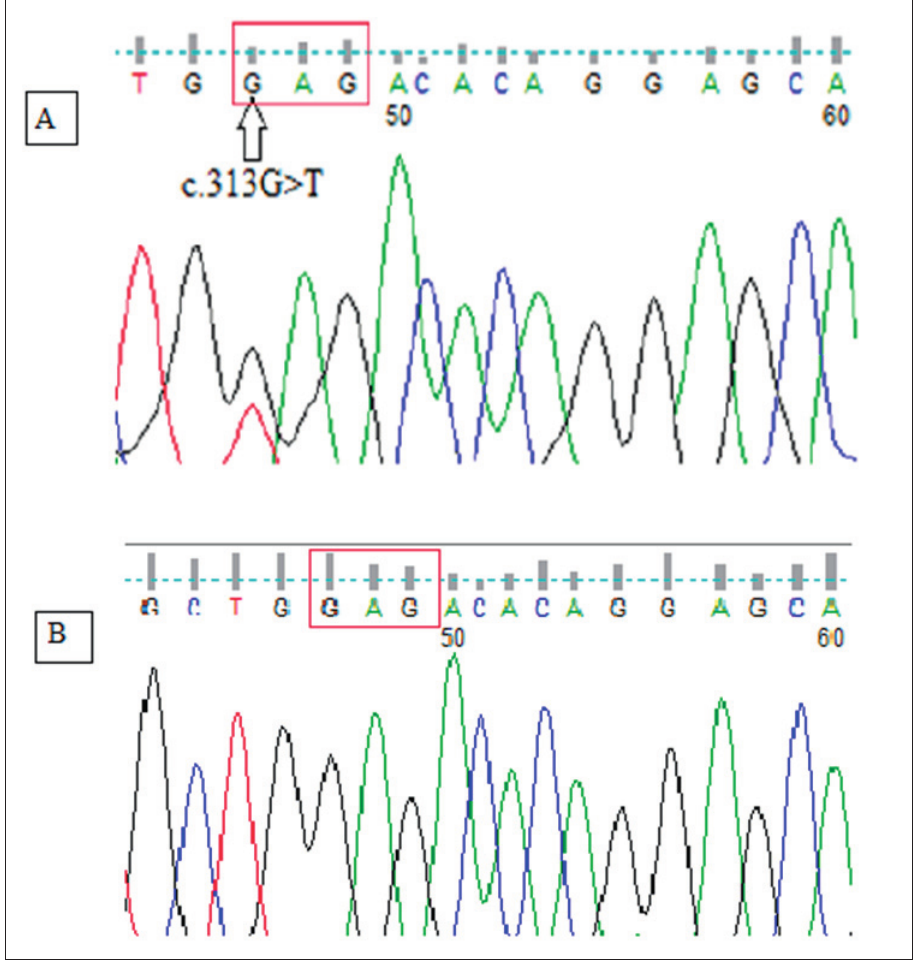
Fig. 1. Electropherogram showing sequencing of exon 4, A shows heterozygous mutation in patient FA-17 by arrow head, B shows the normal sequence in a